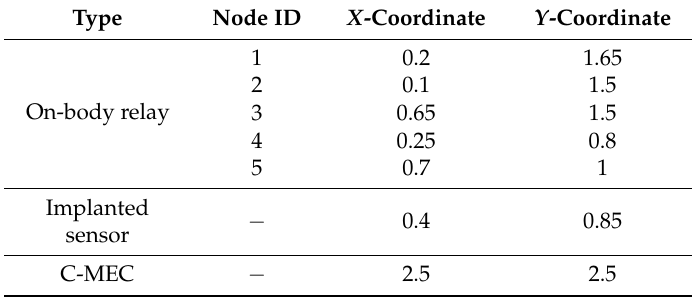
Table 1. Coordinates of on-body relays, implanted sensor, and coordinator-based mobile edge computer